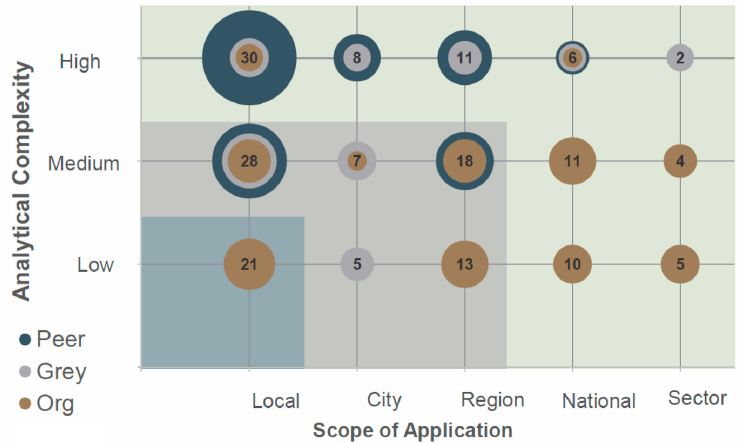
Figure 4. Analytical complexity versus scope of application by literature source.